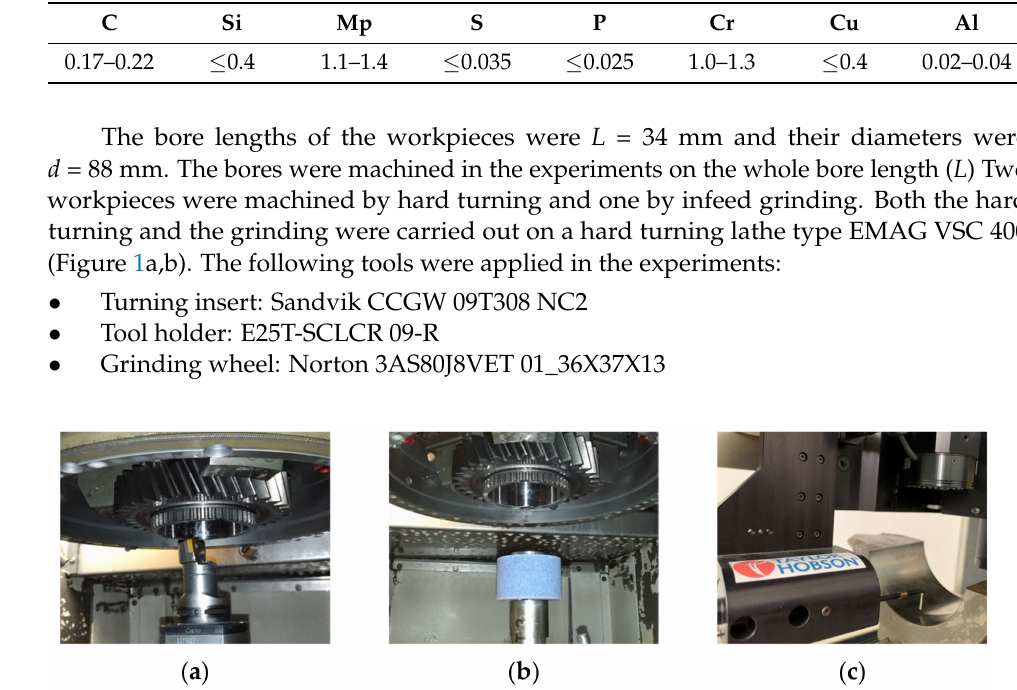
Table 2. Chemical composition of 20MnCr5.